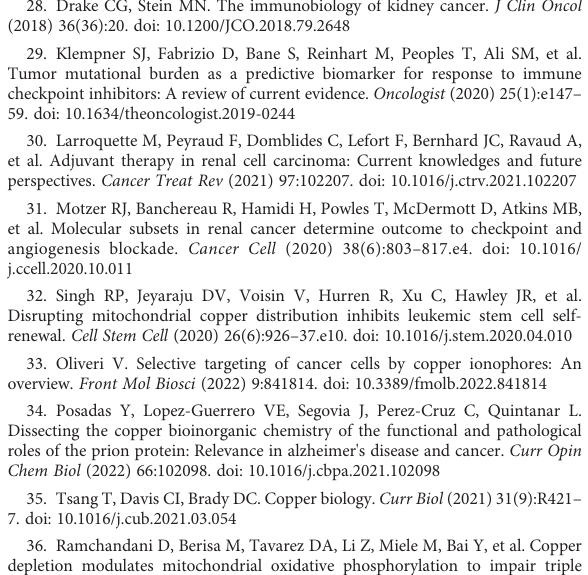
SUPPLEMENTARY FIGURE 3 The application merit of CuproScore in the E-MTAB-1980 cohort.